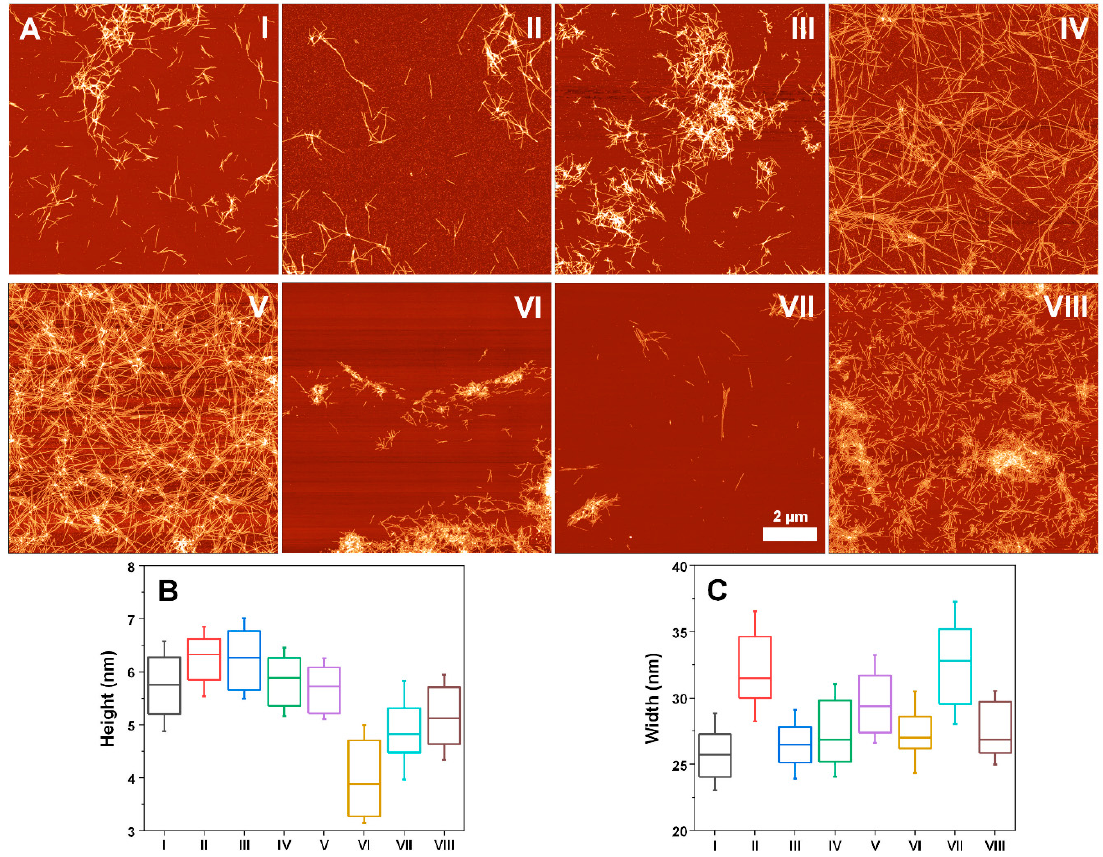
Figure 5. Atomic force microscopy images of α -syn fibrils, which had distinct second derivative FTIR spectra ( A ) and their height ( B ) and width ( C ) distribution ( n = 50). Roman numerals correlate with Figure 4 FTIR spectra. Box plots indicate the interquartile range and the error bars are one standard deviation.